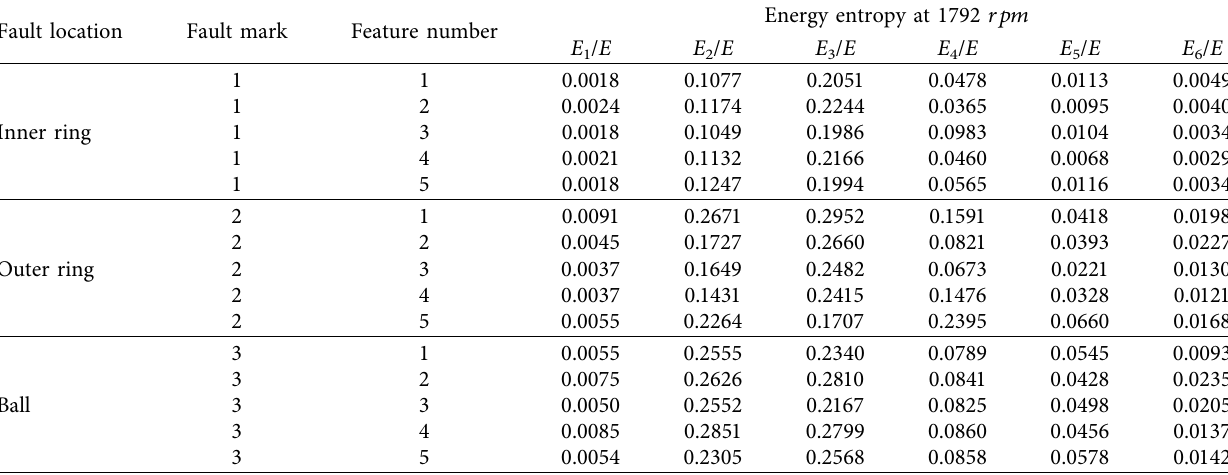
Table 4: Energy entropy at 1792